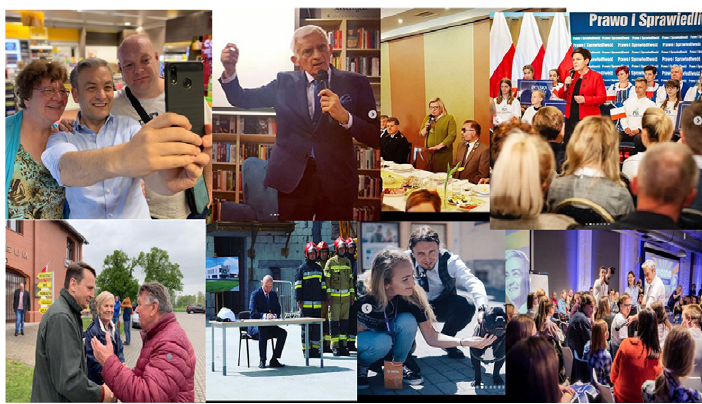
Figure 2. Photos showing candidates “in the field” engaging in interactions and “debate” ( topos of the representative) (source: Instagram